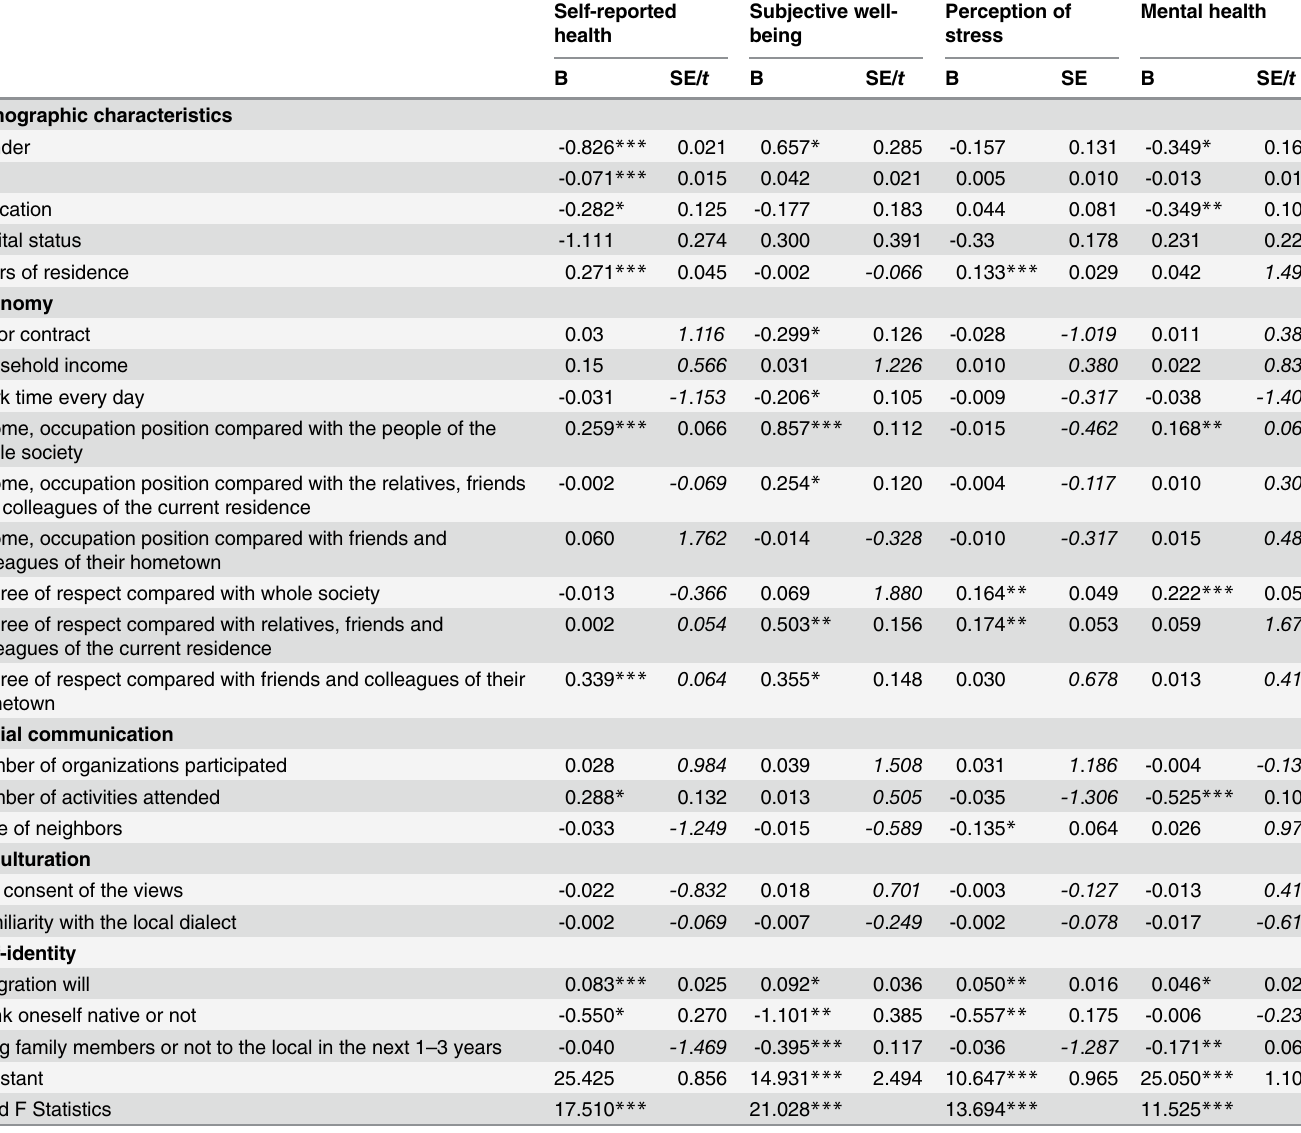
Table 5. Coefficients of Multi-variate Regressions of the Relationship between Social Integration and Health among Internal Migrants in Zhong- Shan, China.